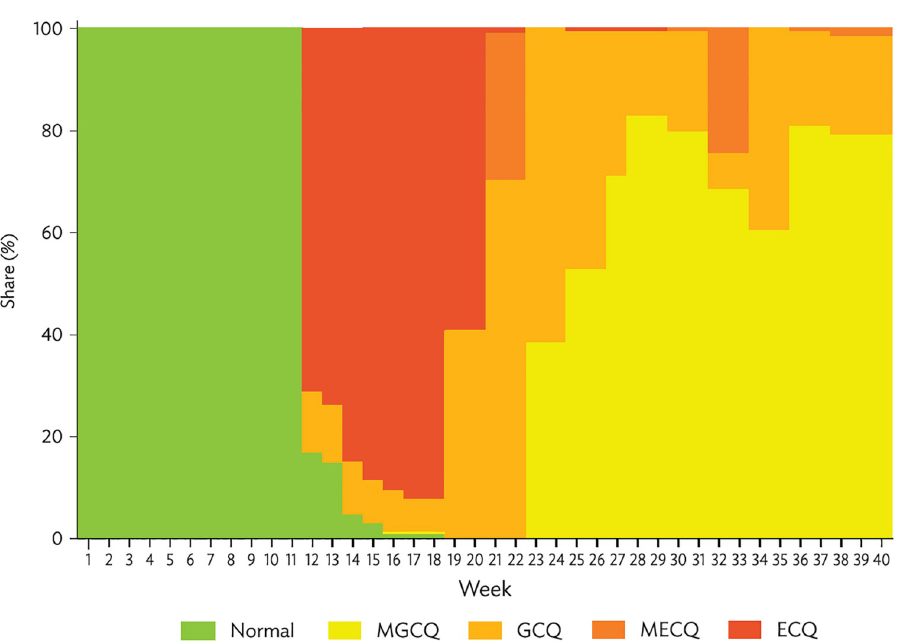
Fig 2. Share of community quarantine measures by week among top 300 destinations. ECQ = enhanced community quarantine; GCQ = general community quarantine; MECQ = modified enhanced community quarantine; MGCQ = modified general community quarantine. Note: Lockdown policies data is obtained from the Government of the Philippines. Official Gazette . https://www.officialgazette.gov.ph/section/laws/other-issuances/inter-agency-task- force-for-the-management-ofemerging-infectious-diseases-resolutions/. Source: Authors’ calculations.